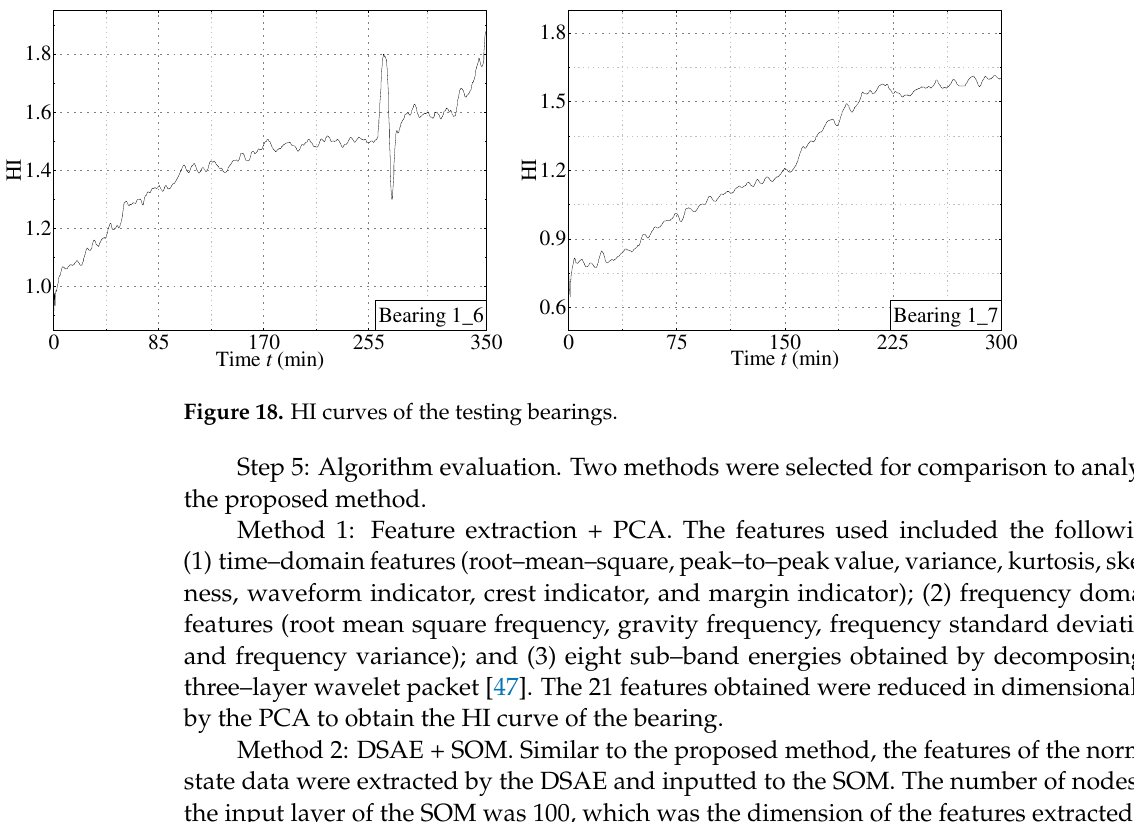
Figure 17. HI curves of the training bearings. Step 4: Validation using testing datasets. The data from the testing datasets were se- quentially inputted into the trained DSAE and SVDD models. Subsequently, the HI curves for each bearing in the testing datasets were obtained, as shown in Figure 18.